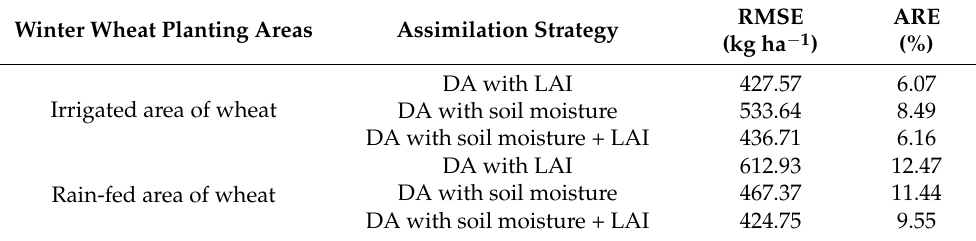
Table 2. Accuracy verification of the assimilation model in yield estimation of winter wheat.